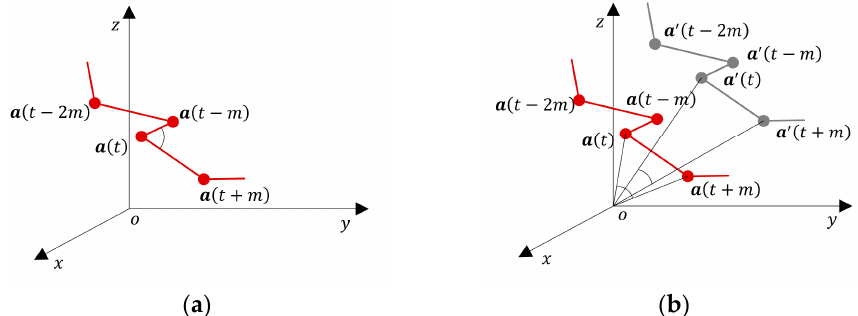
Figure 3. Demonstration for orientation invariant features in 3D subsequence plotted in the sensor coordinate system. ( a ) the angle between vector a ( t ) a ( t + m ) and vector a ( t ) a ( t − m ) used to encoding AE-GDI keeps invariant when rotation, translation and even scaling are applied on a ; ( b ) a (cid:48) is a copy of a after applying translation on it. Obviously, the inner product of two acceleration vectors at time t and t + m in a (cid:48) is different from that in a The encoding strategy of AE-GDI is similar to that of GDI [9]. Given row index (cid:1861) and column